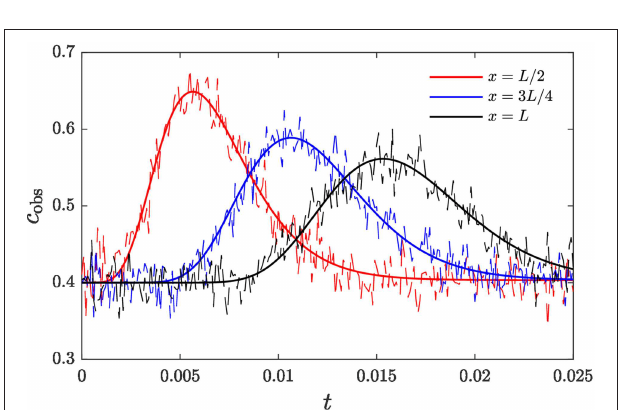
FIGURE 1 | Breakthrough curves of contaminant at observation locations along the transport domain. Noisy measurements used for inference are shown in dashed.